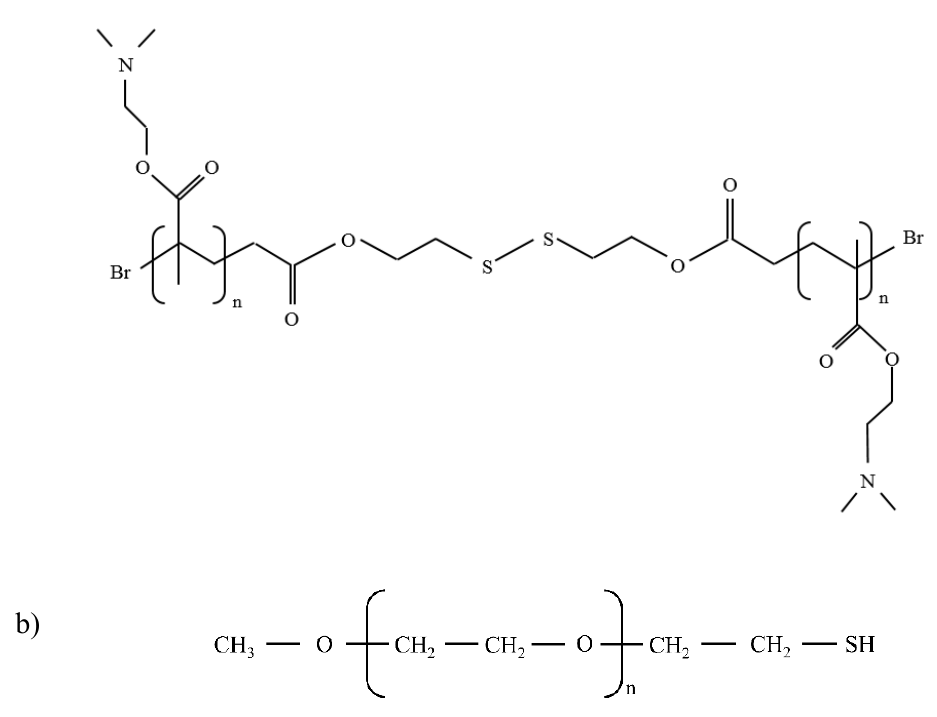
Figure 1. Chemical structure of PDMAEMA ( a ) and PEO (PEO1, n = 23 units, PEO2, 43 units, PEO5, n = 112 units) ( b ).